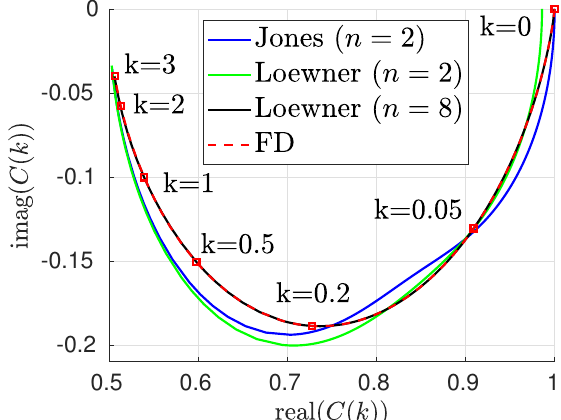
Figure 3. Theodorsen function in the complex plane and corresponding Jones approximation and Loewner